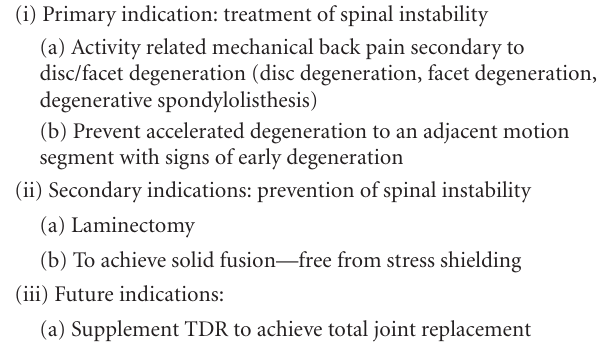
Table 1: Classification of the pedicle screw-based posterior dynamic stabilization devices.